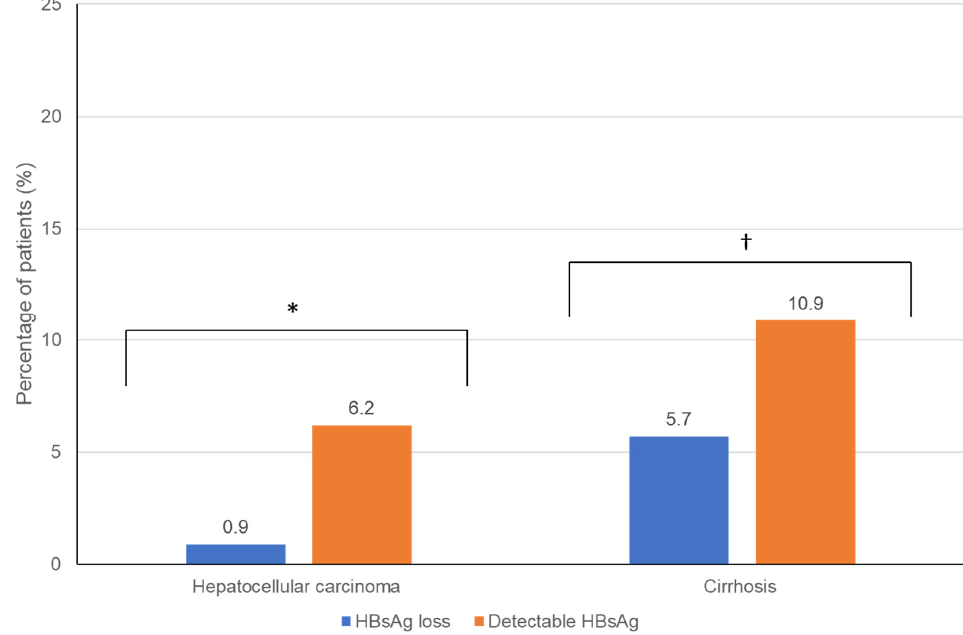
Figure 1. Percentage of CHB patients who achieved HBsAg loss vs. those remaining HBsAg-positive who developed the end-stage liver disease (i.e., HCC and cirrhosis). * p < 0.001. † p ≤